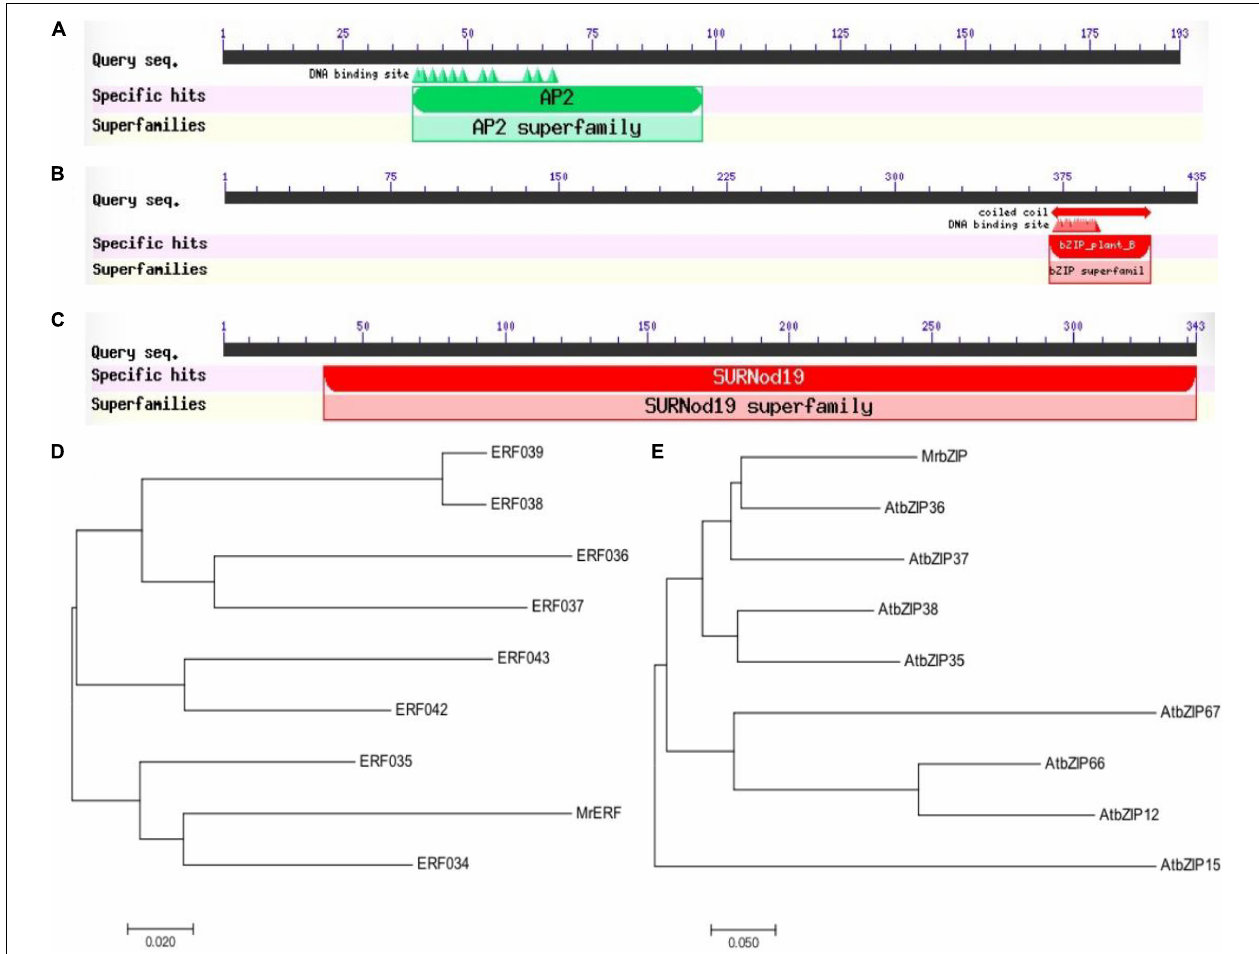
FIGURE 1 | Prediction of the conserved domains, phylogenetic tree. (A) Conserved domain of MrERF ; (B) conserved domain of MrbZIP ; (C) conserved domain of MrSURNod ; (D) phylogenetic tree of MrERF ; and (E) phylogenetic tree of MrbZIP .